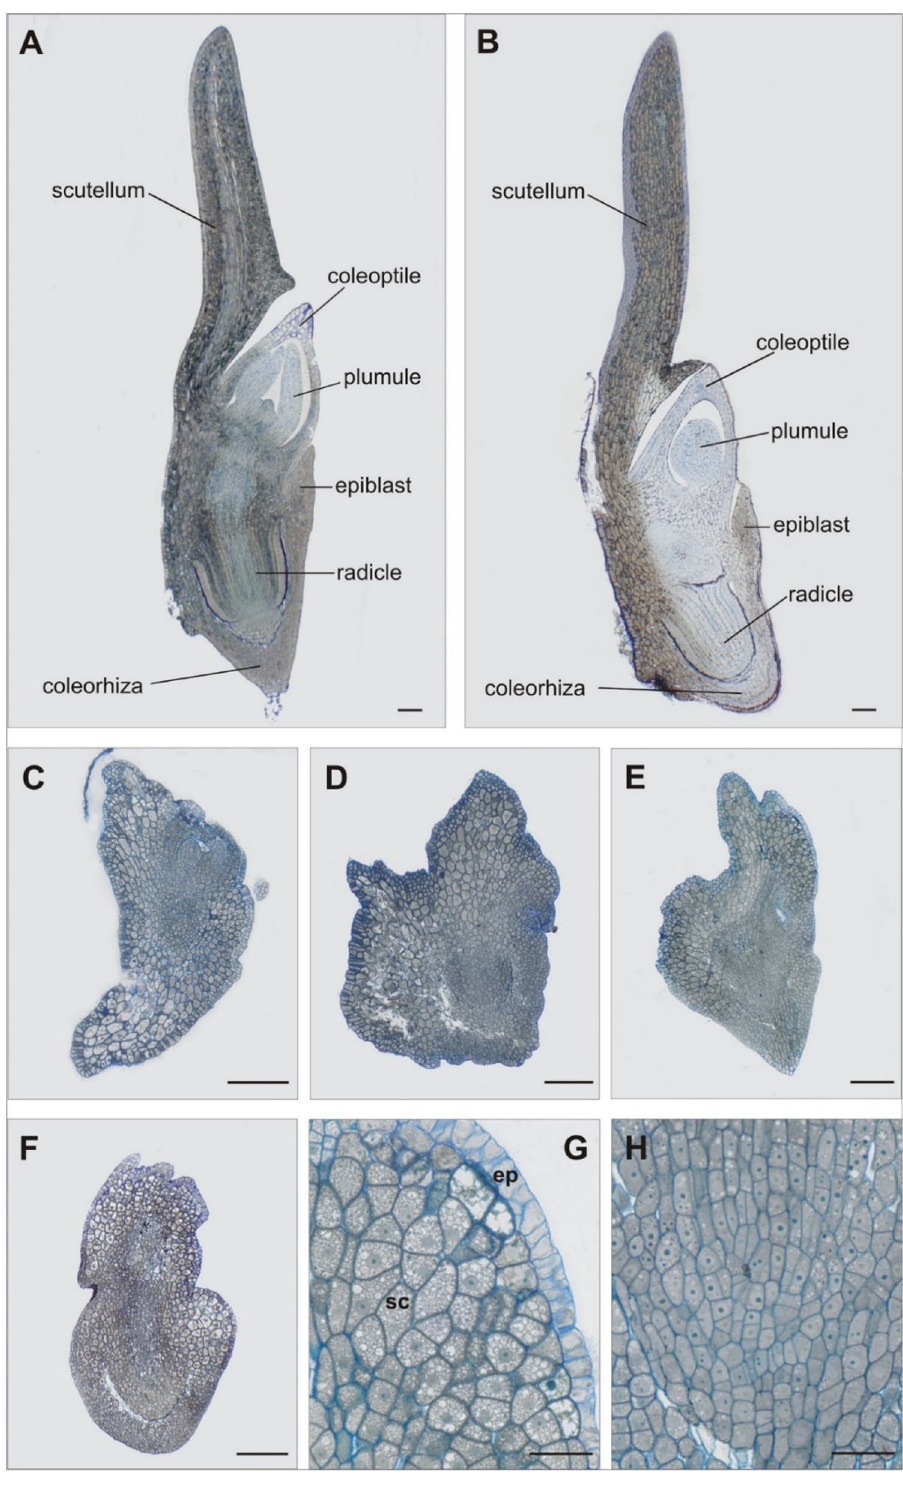
Figure 2. Anatomical sections of oat embryos. ( A ) zygotic embryo cv. ‘Krezus’, ( B ) zygotic embryo cv. ‘Akt’, ( C , D ) haploid embryos cv. ‘Krezus’, ( E – H ) haploid embryos cv. ‘Akt’, ( G ) greater magnification of vacuolized large parenchyma cells building the scutellum (sc) and epithelial layer (ep), ( H ) division zone of the apical part of the root. Scale: ( A – F ) 200 µm; ( G , H ) 50